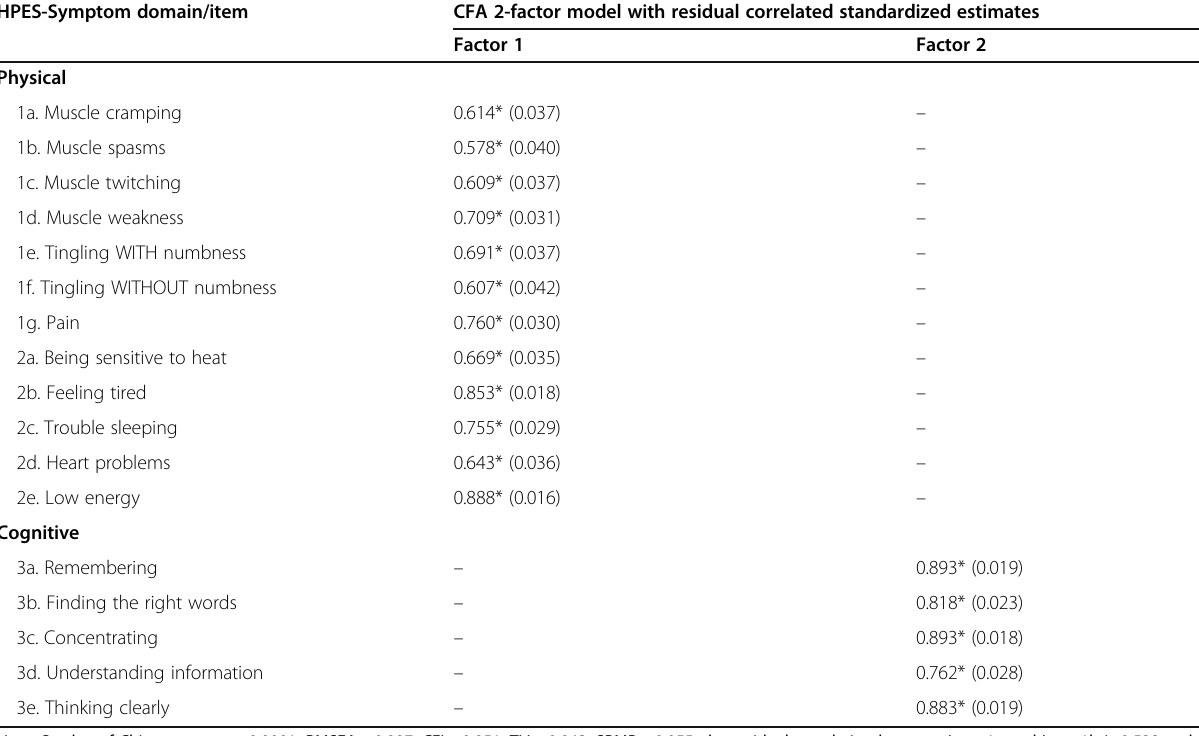
Table 1 CFA two-factor model – factor loadings (SEs) and fit indices - baseline HPES-Symptom using observational study data HPES-Symptom